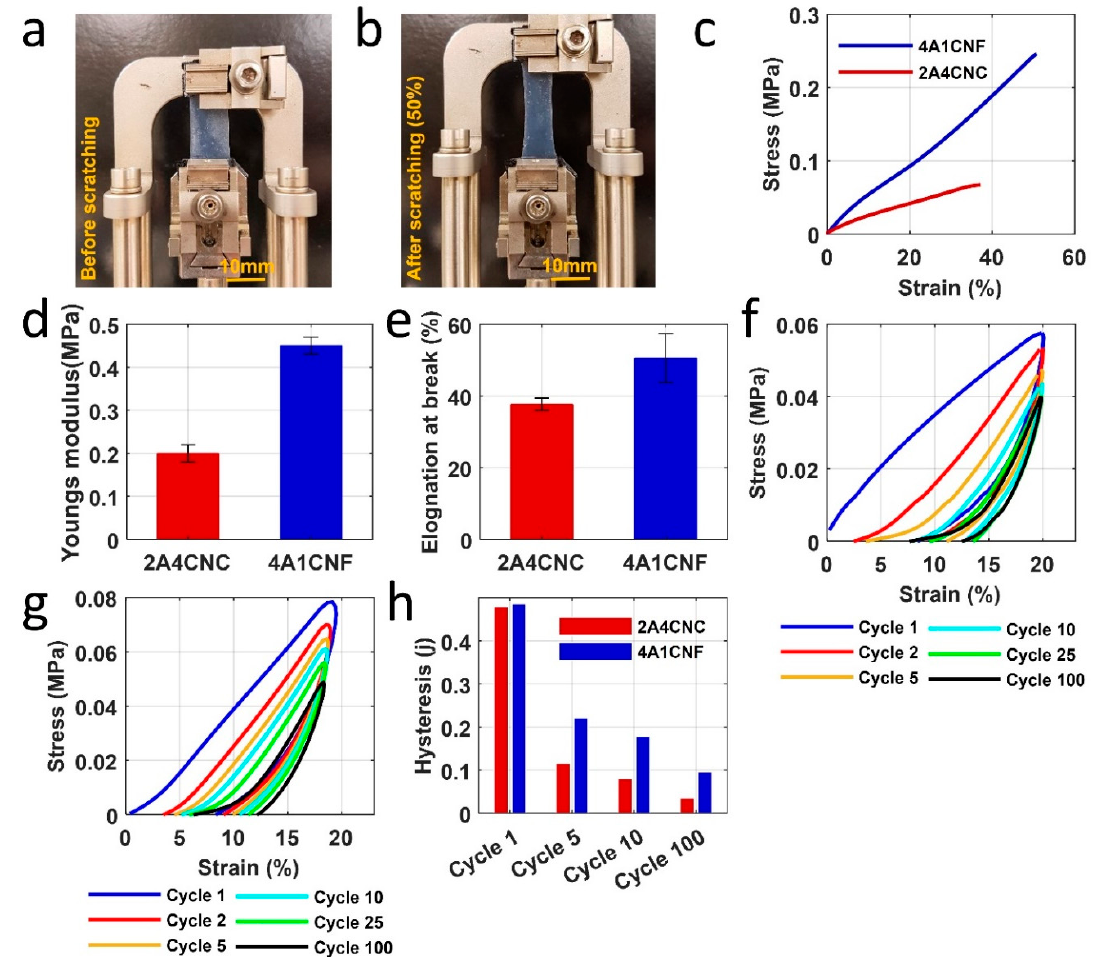
Figure 4. Mechanical characterization of 3D printed patches. ( a , b ) Images of 4A1CNF before stretching and 50% elongation under tensile tests. ( c ) Stress-strain curve of two samples under a ramped fore rate of 0.1 N/min. ( d ) Young’s modulus from the slope in the initial linear region of the stress-strain curve for two samples. ( e ) Maximum elongation of sample right before the samples fractured. Cycling loading in DI water to assess the hysteresis, deformation over cycling that mimics the movement in the skin for ( f ) 2A4CNC and ( g ) 4A1CNF. The sample was scratched repeatedly for 100 cycles at strain ramp 10%/min to 20% strain. ( h ) Hysteresis versus the number of cycling from the stress-strain curve of the inside area of loading and unloading.